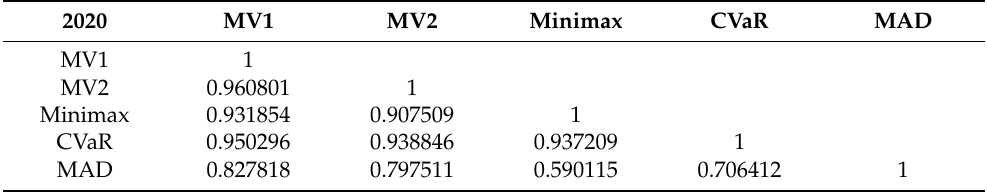
Table A6. Correlation coefficients among portfolio values based on “buy and hold” strategy in 2020.